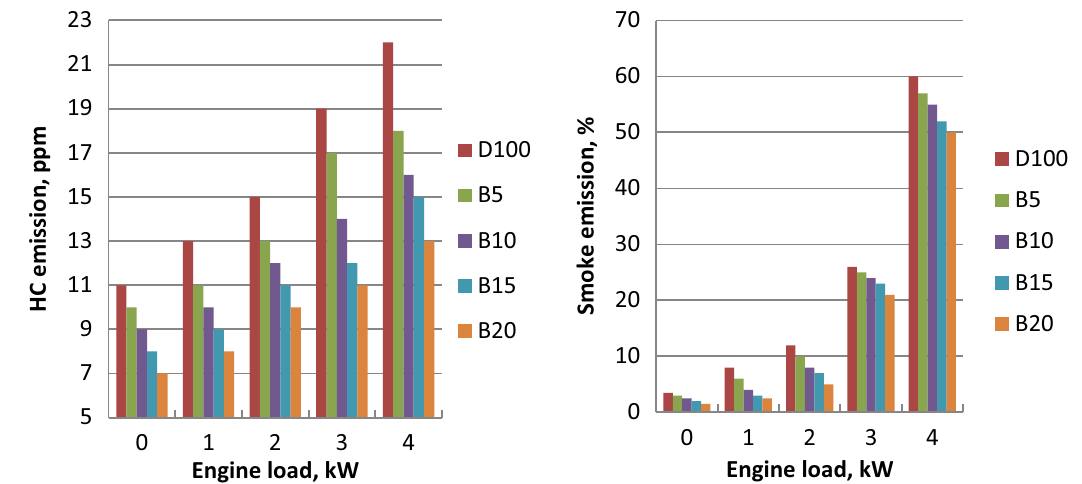
Figure 6. Variations of unburned hydrocarbon and smoke opacity with engine loads.